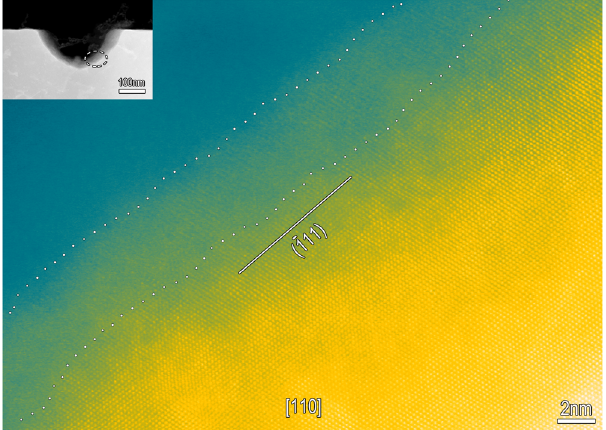
Fig. 4 Transpassivation induces the concave wall along close-packed plane. High-resolution HAADF-STEM image at the concave wall along the [110] axis of the FeCr15Ni15 matrix, showing the transpassive fi lm/matrix interface along the ( − 111) close-packed plane of the austenitic matrix, also in addition to the exposed close-packed plane of the highly-crystalline transpassive fi lm. The transpassive fi lm is found to preferentially grow epitaxially on the single-crystal matrix, with the exposed surface parallel to the interface at nanometer and even atomic scale. Insert shows a deeper concave, where the labeled zone with a dashed line is